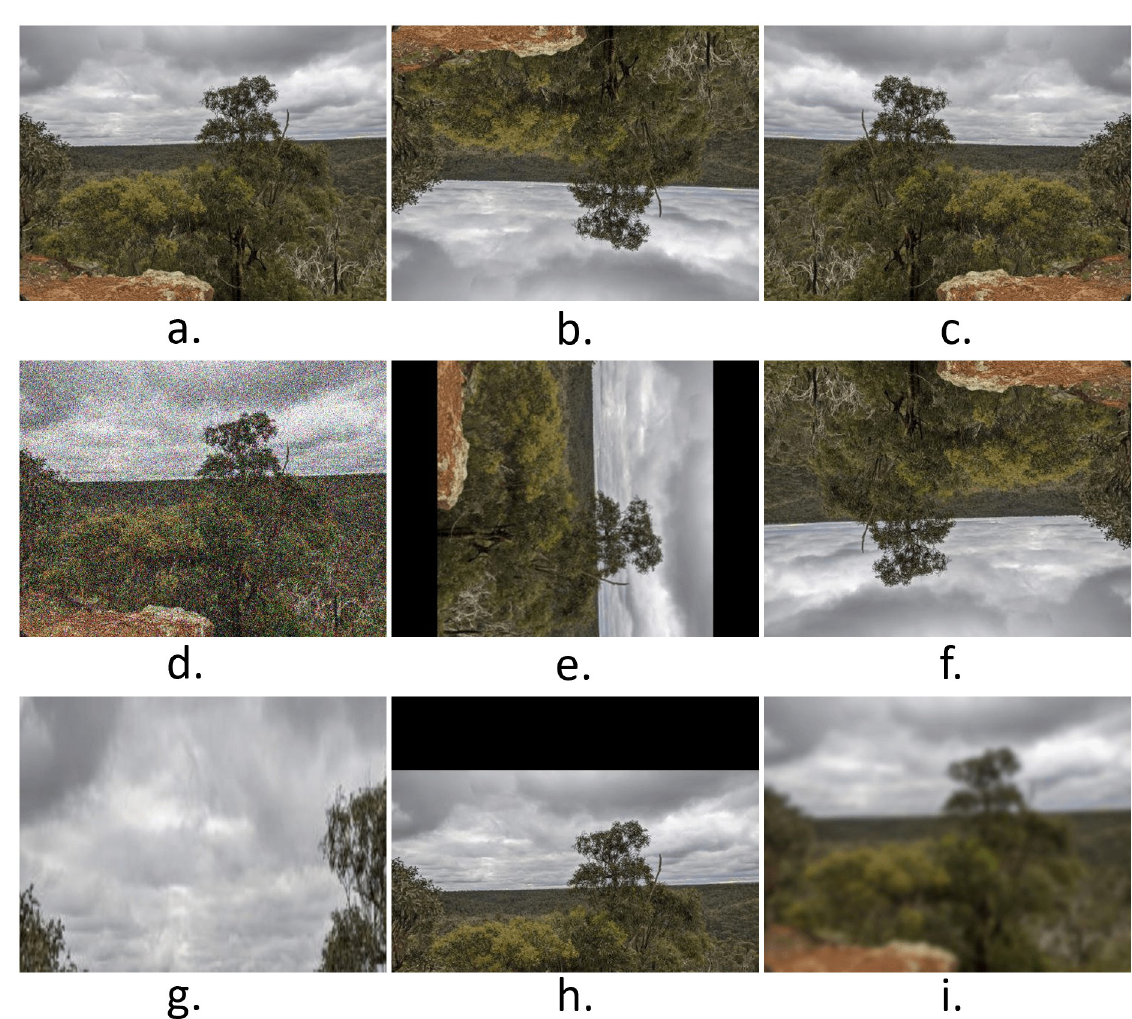
Fig 7. Different data augmentation technique applied include: (a). Original Image, (b). Vertical Flip, (c). Horizontal Flip, (d) Random Gaussian Noise, (e). 90 degree rotation, (f). 180 degree rotation, (g). Random zoom, (h). Translation, and (i). Blur.